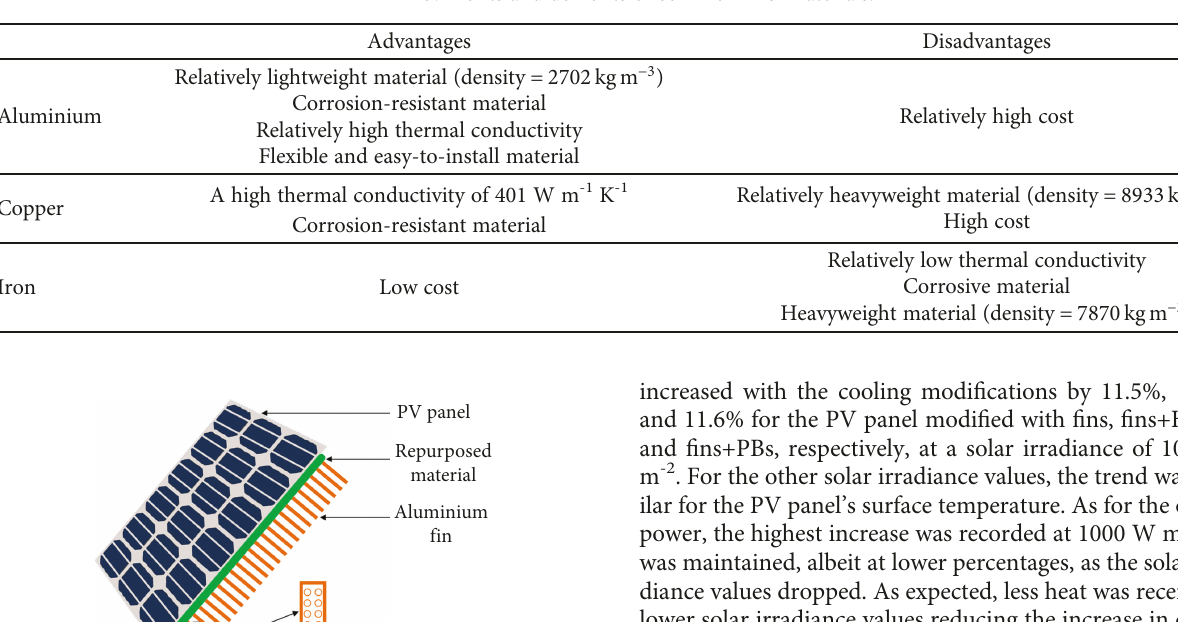
Table 3: Merits and demerits of common fi ns ’ materials.